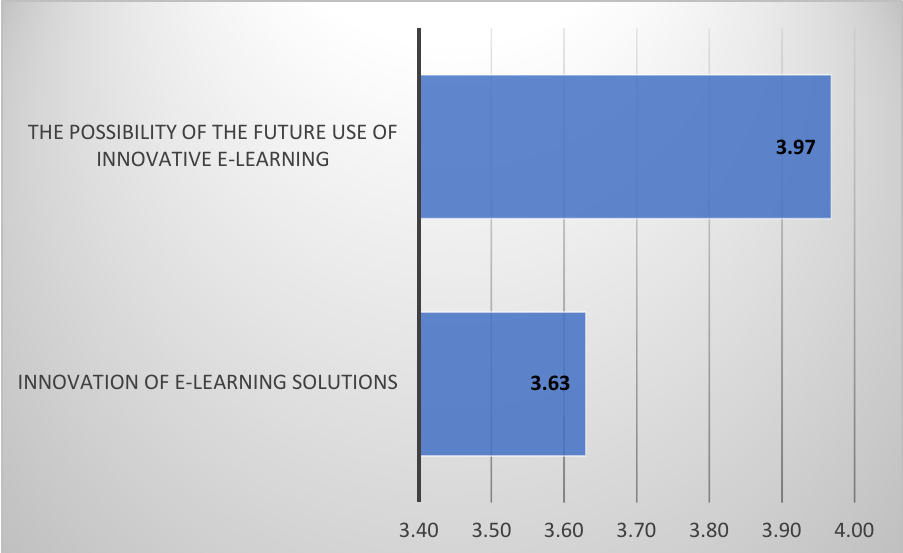
Figure 11. Innovation of e-learning solutions.